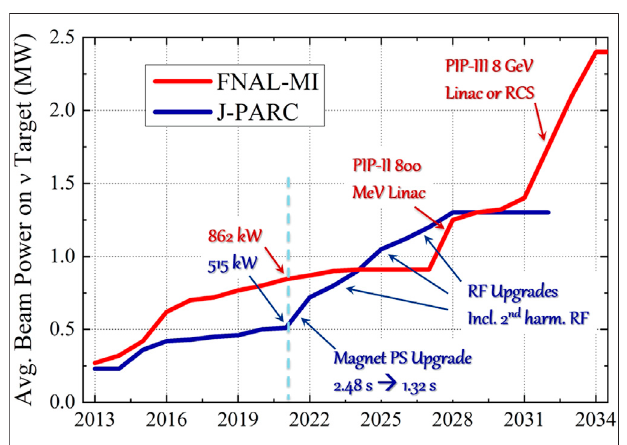
FIGURE 3 | Beam power progress and plans for J-PARC and Fermilab